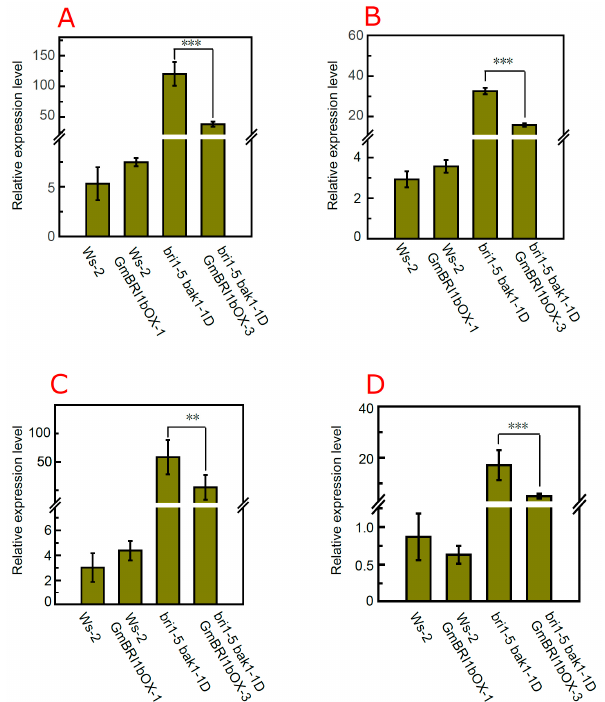
Figure 8. Effect of ectopic over-expression of GmBRI1b on the expression of BR biosynthesis-related genes in the transgenic bri1-5 bak1-1D mutant. Seedlings were grown as described in Materials and Methods. qRT-PCR was used to detect the relative expression levels of: DWF4 ( A ); CPD ( B ); BR6ox-1 ( C ); and BR6ox-2 ( D ) in Ws-2 and bri1-5 bak1-1D mutant and their corresponding over-expression lines. Results are means ± SD from three independent experiments with three technical replicates (Student’s t -test, ** p < 0.01, *** p < 0.001).